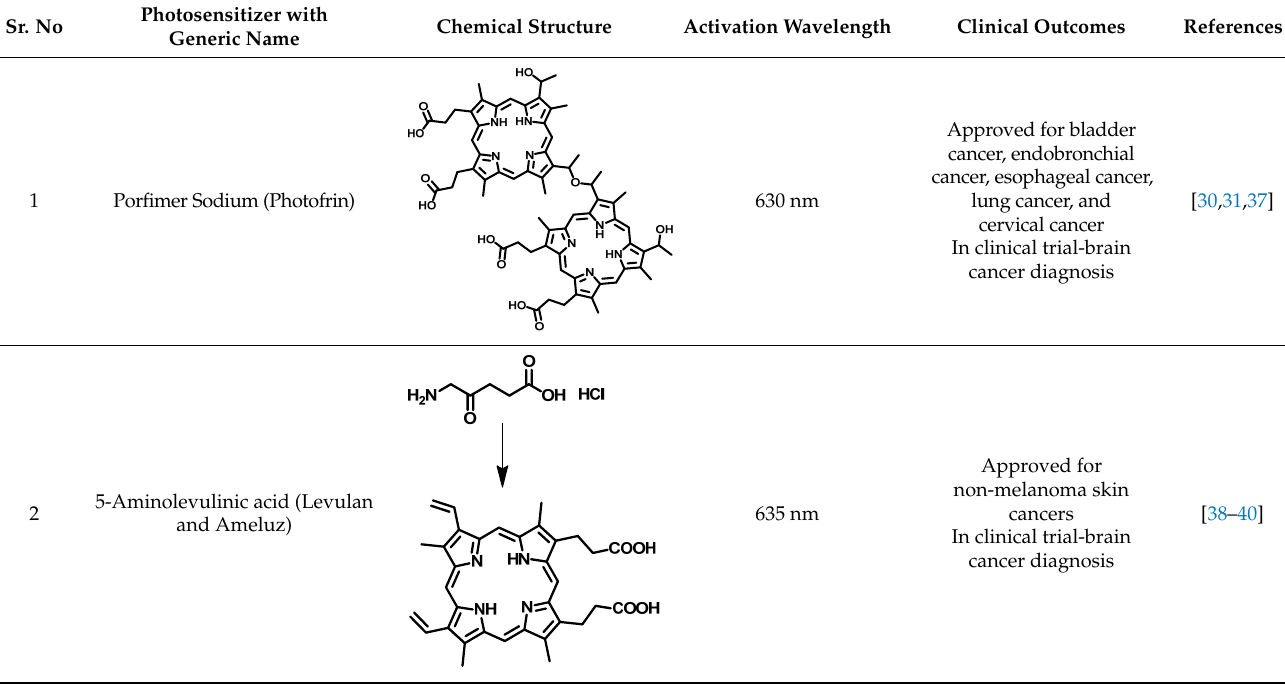
Table 1. Represents the clinical trials and approval status of various photosensitizers [30–44].